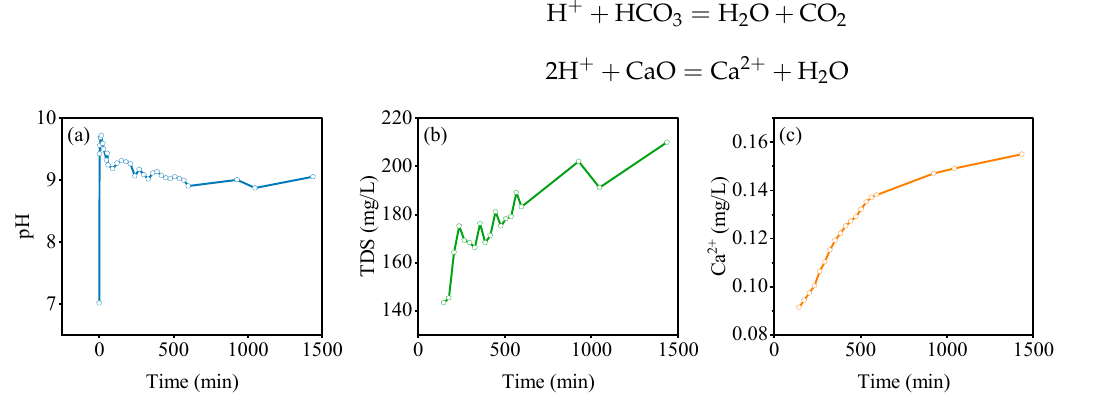
Figure 7. Solution characteristics of the muddy siltstone after leaching with deionized water: ( a ) pH value; ( b ) TDS concentration; ( c ) Ca 2+ concentration.